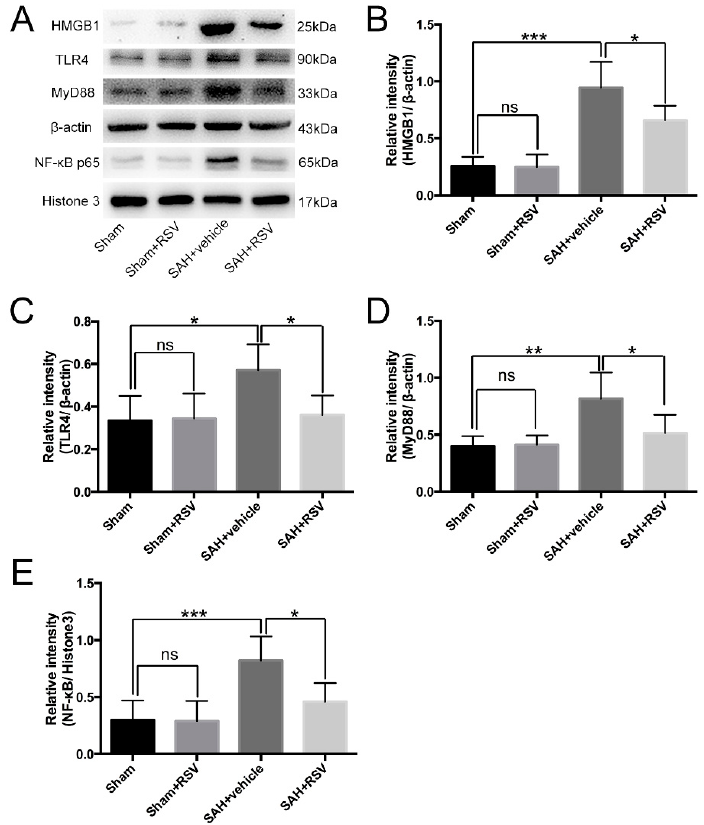
Figure 2. Effects of resveratrol (RSV) on the expression and activation of toll-like receptor 4 (TLR4)-related pathway 24 h post subarachnoid hemorrhage (SAH). ( A ) Representative Western blot images to detect the effects of RSV on the expressions of high-mobility group box 1 (HMGB1), TLR4, myeloid differentiation factor 88 (MyD88), and nuclear factor- κ B (NF- κ B); (B–E) Quantitative analyses of HMGB1, TLR4, MyD88, and NF- κ B among all experimental groups. RSV treatment significantly reduced HMGB1, TLR4, MyD88, and NF- κ B protein levels as compared with SAH + vehicle group. Bars represent the mean ± SD. *** p < 0.001, ** p < 0.01, * p < 0.05, and ns means non-significant.